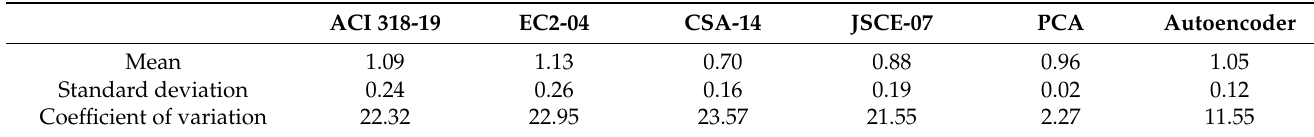
Figure 4. Comparisons between predicted and measured torsional strength of the validation dataset. ( a ) Current design codes; ( b ) ANN models. Table 4. Statistical values of the validation